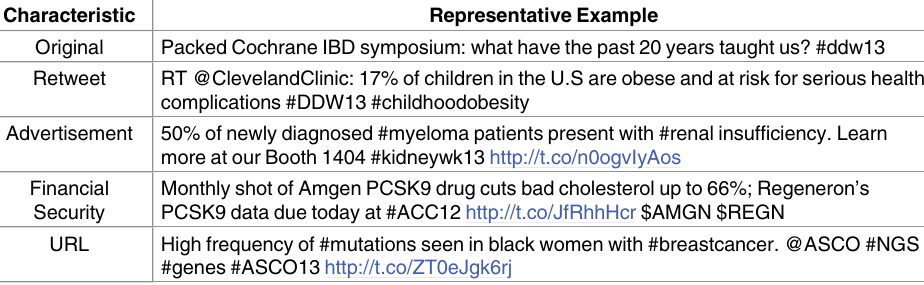
Table 2. Categories and examples of Tweets based on content.